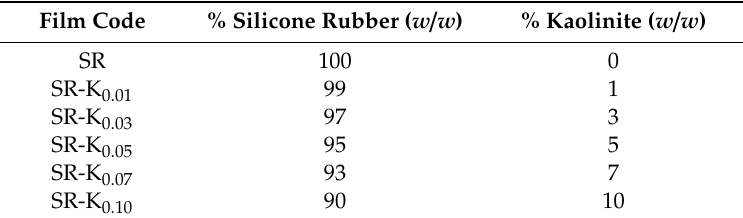
Table 1. Nanocomposite (NCP) films fabricated with di ff erent filler loading. SR-K = silicone rubber-